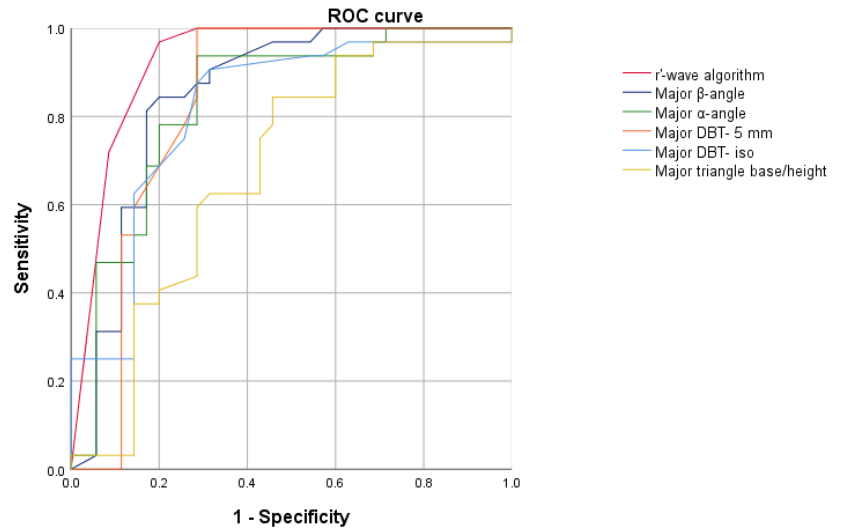
Figure 4. Receiver operating characteristic analyses of r’-wave algorithm, β -angle, α -angle, DBT- 5 mm, DBT- iso, and triangle base/height ratio to identify a BrS diagnosis after Sodium Channel Blocker Provocation Test in the test cohort. Table 2. Comparison of baseline clinical characteristics of the test cohort based on Brugada syndrome diagnosis after Sodium Channel Blocker Provocation Test.